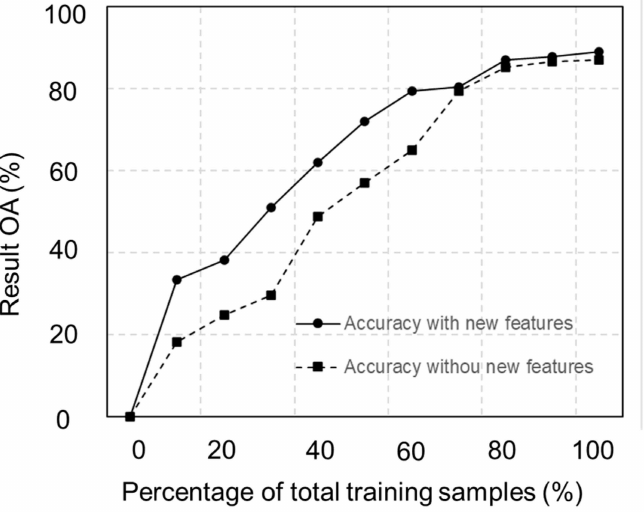
Figure 9. Relationship between result overall accuracy and sample size (%). Two feature schemes are compared: with four phenology and three morphology features and without these seven